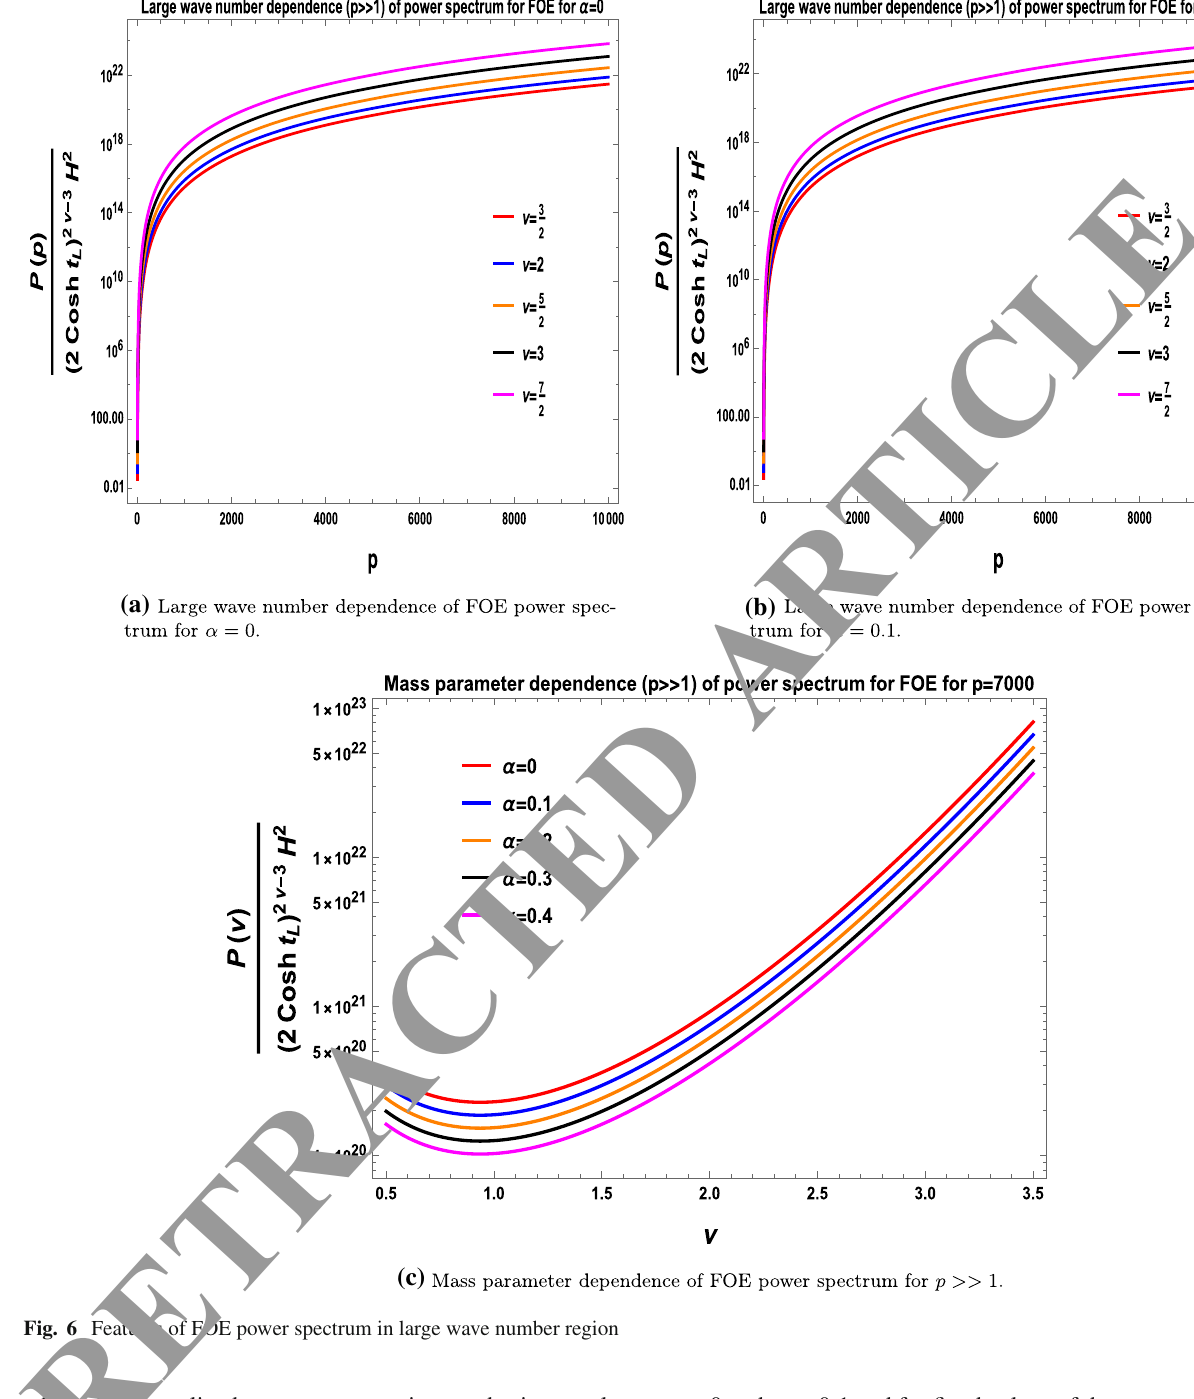
Fig. 6 Features of FOE power spectrum in large wave number